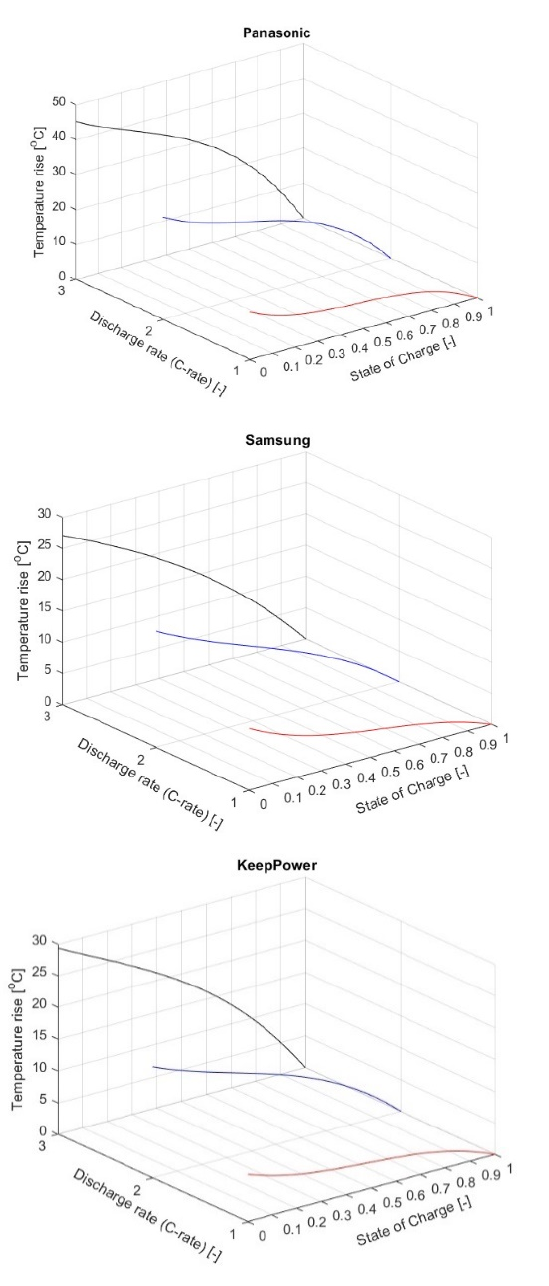
Figure 6. Thermal maps for the studied batteries (Panasonic- NCA, Samsung-NMC, KeepPower- LCO).